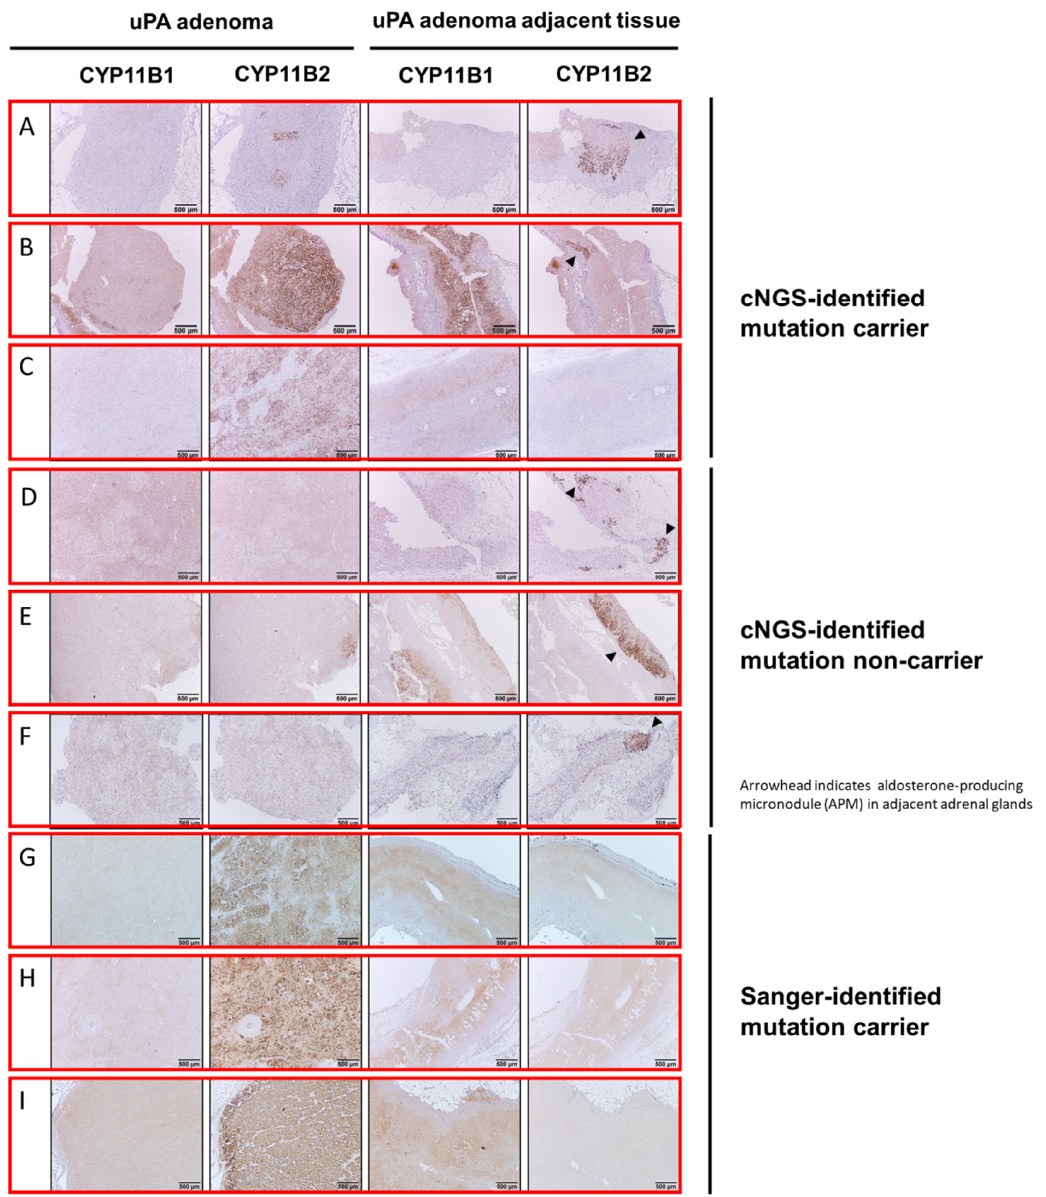
Figure 4. Histopathologic finding of tumoral and adjacent tissues of unilateral primary aldosteronism with respect to detected mutations via customized targeted next-generation sequencing. Higher magnification view of aldosterone- producing adenoma ( A , B , C , E ), and the CYP11B2-negative adenoma ( D , F ) with adjacent tissue. CYP11B2 and CYP11B1 IHC were quite variable among cNGS-identified mutation carriers and non-carriers. Arrowhead indicates aldosterone- producing micronodule (formally known as aldosterone-producing cell cluster) in adjacent adrenal glands. At least one aldosterone-producing micronodule could be found in tissues adjacent to the adrenal tumor. Scale bar: 500 µ m. Abbreviations: cNGS, customized targeted next-generation sequencing; uPA, unilateral primary aldosteronism. For these Sanger sequencing-identified mutation carriers, CYP11B2 staining was homogeneous within adenoma ( G – I )